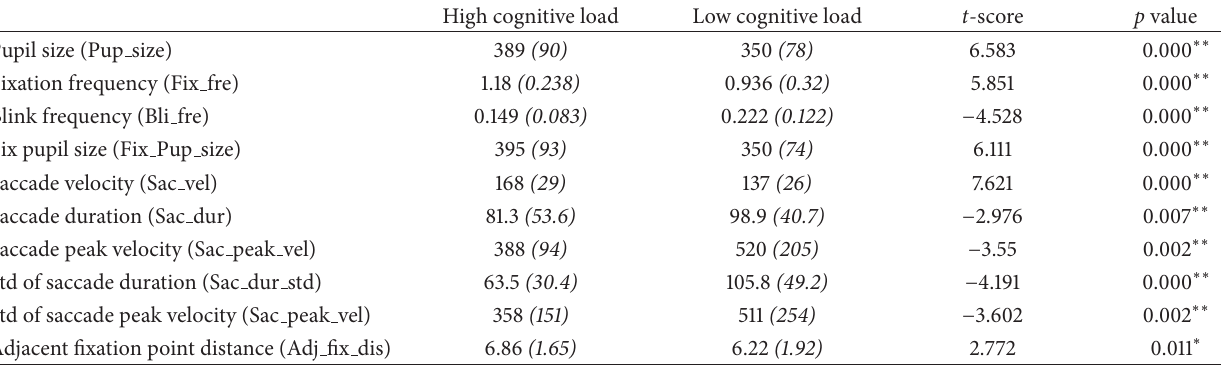
Table 1: The salient features in light controlled condition.